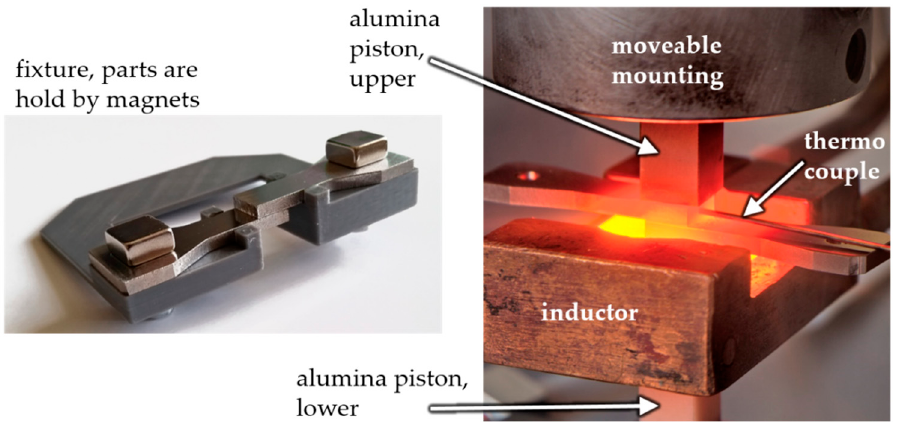
Figure 4. Sample part fixture ( left side) and heated sample during joining process ( right side).